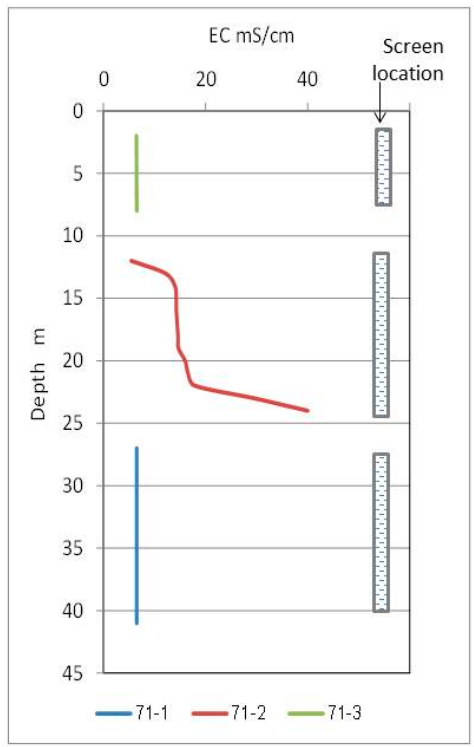
Figure 5. EC profiles in wells 71-3, 71-2, 71-1 penetrating the three Quaternary units (A, B and C, respectively), 70 m from the sea, at the southern site of Ma’agan